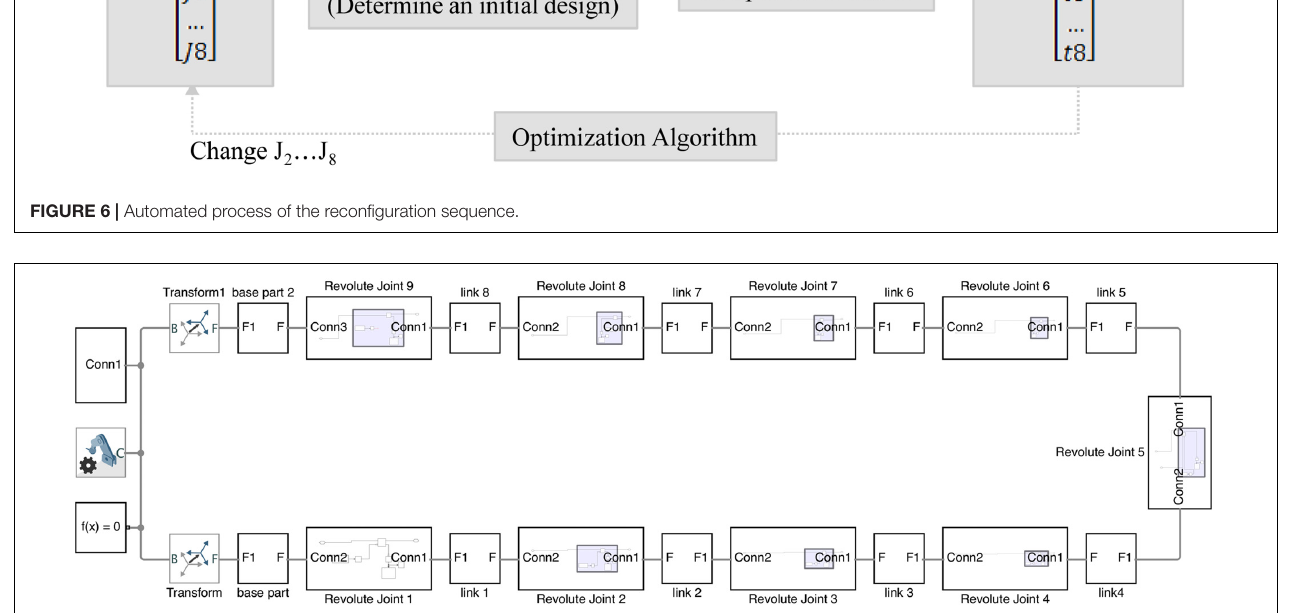
FIGURE 7 | Simulink model with all blocks and